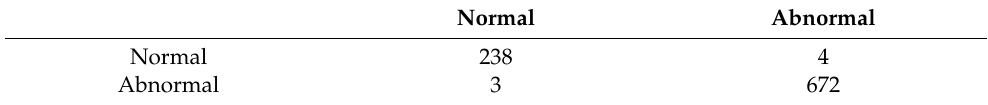
Table 3. The confusion matrix of the proposed cervical cancer classification on the Herlev dataset [3]. Normal